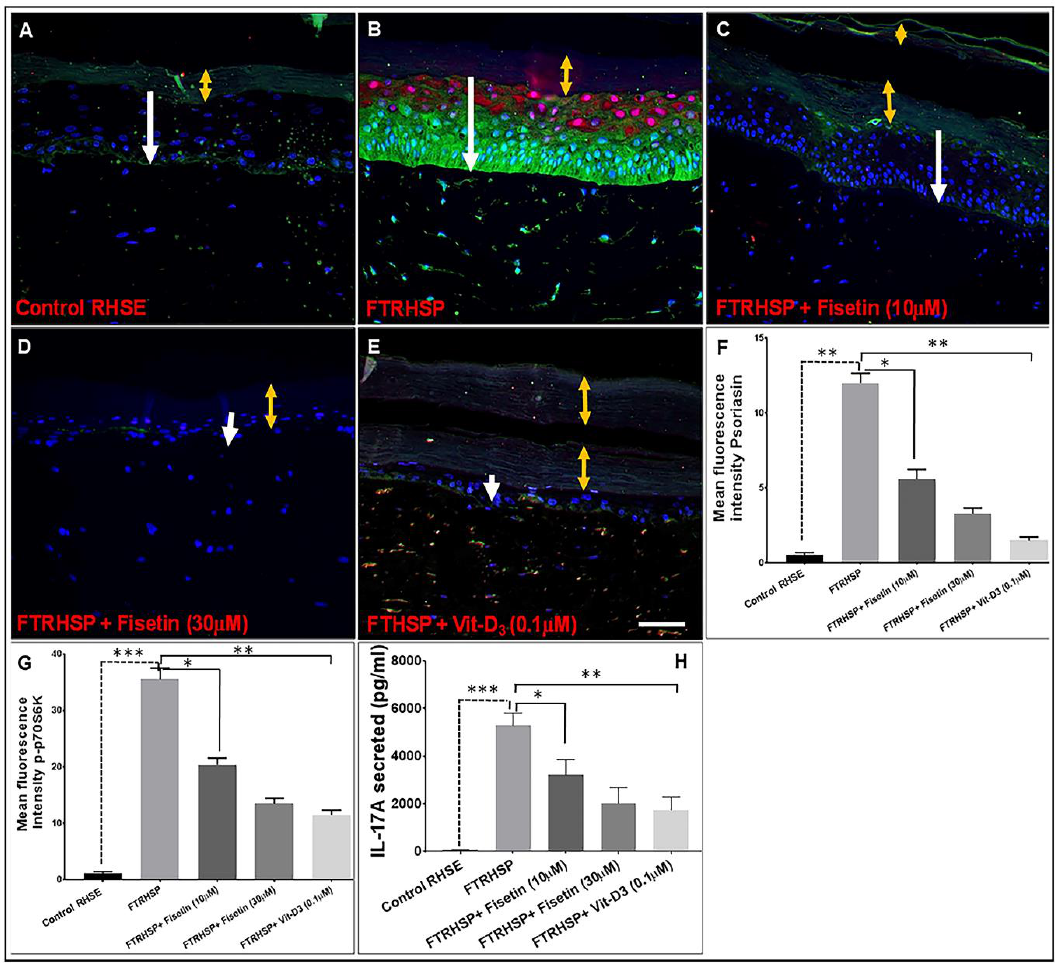
Figure 10. Fisetin modulated the expression of makers of psoriasis-like inflammation and mTOR activity in 3D human skin model of psoriasis. Immunofluorescence staining for p-p70S6K and Psoriasin was performed on FTRHSP sections by incubating with primary antibody against targets overnight at 4 °C followed by incubation with specific Alexa Flour 488-labeled secondary antibodies for 2 h at room temperature in the dark. Samples were mounted in mounting medium containing 4 ′ ,6-diamidino-2-phenylindole (DAPI) and analyzed microscopically. ( A – E ) the antimicrobial peptide (psoriasin) and mTOR activation effector, p-p70S6K stainings are shown in red and green, respectively, and DAPI in blue. Representative pictures are shown. Scale bar = 20 μm. The yellow arrows delineate the thickness of the stratum corneum, while the white arrows indicate the thickness of the viable epidermis. ( F , G ) For densitometric quantification, each color image was separated into its green, blue, and red channel components using ImageJ software (National Institutes of Health, Bethesda, MD, USA), and green and red channels were used to analyze mean fluorescent intensity. Data shown here are mean fluorescence intensity ± SEM. ( H ) Differential protein expression levels of IL-17A secreted in the conditioned media of FTRHSP cultures. Pro-inflammatory cytokines IL-17A in conditioned media, were analyzed when 3D FTRHSP were treated without and with fisetin (10 – 30 µM) treatment or 0.1 µM Vit-D 3 for five days following activation by co-culturing with anti-CD3 / CD28 activated CD4 + T cells for seven days as described in Section 2.12. Significant di ff erences were determined and